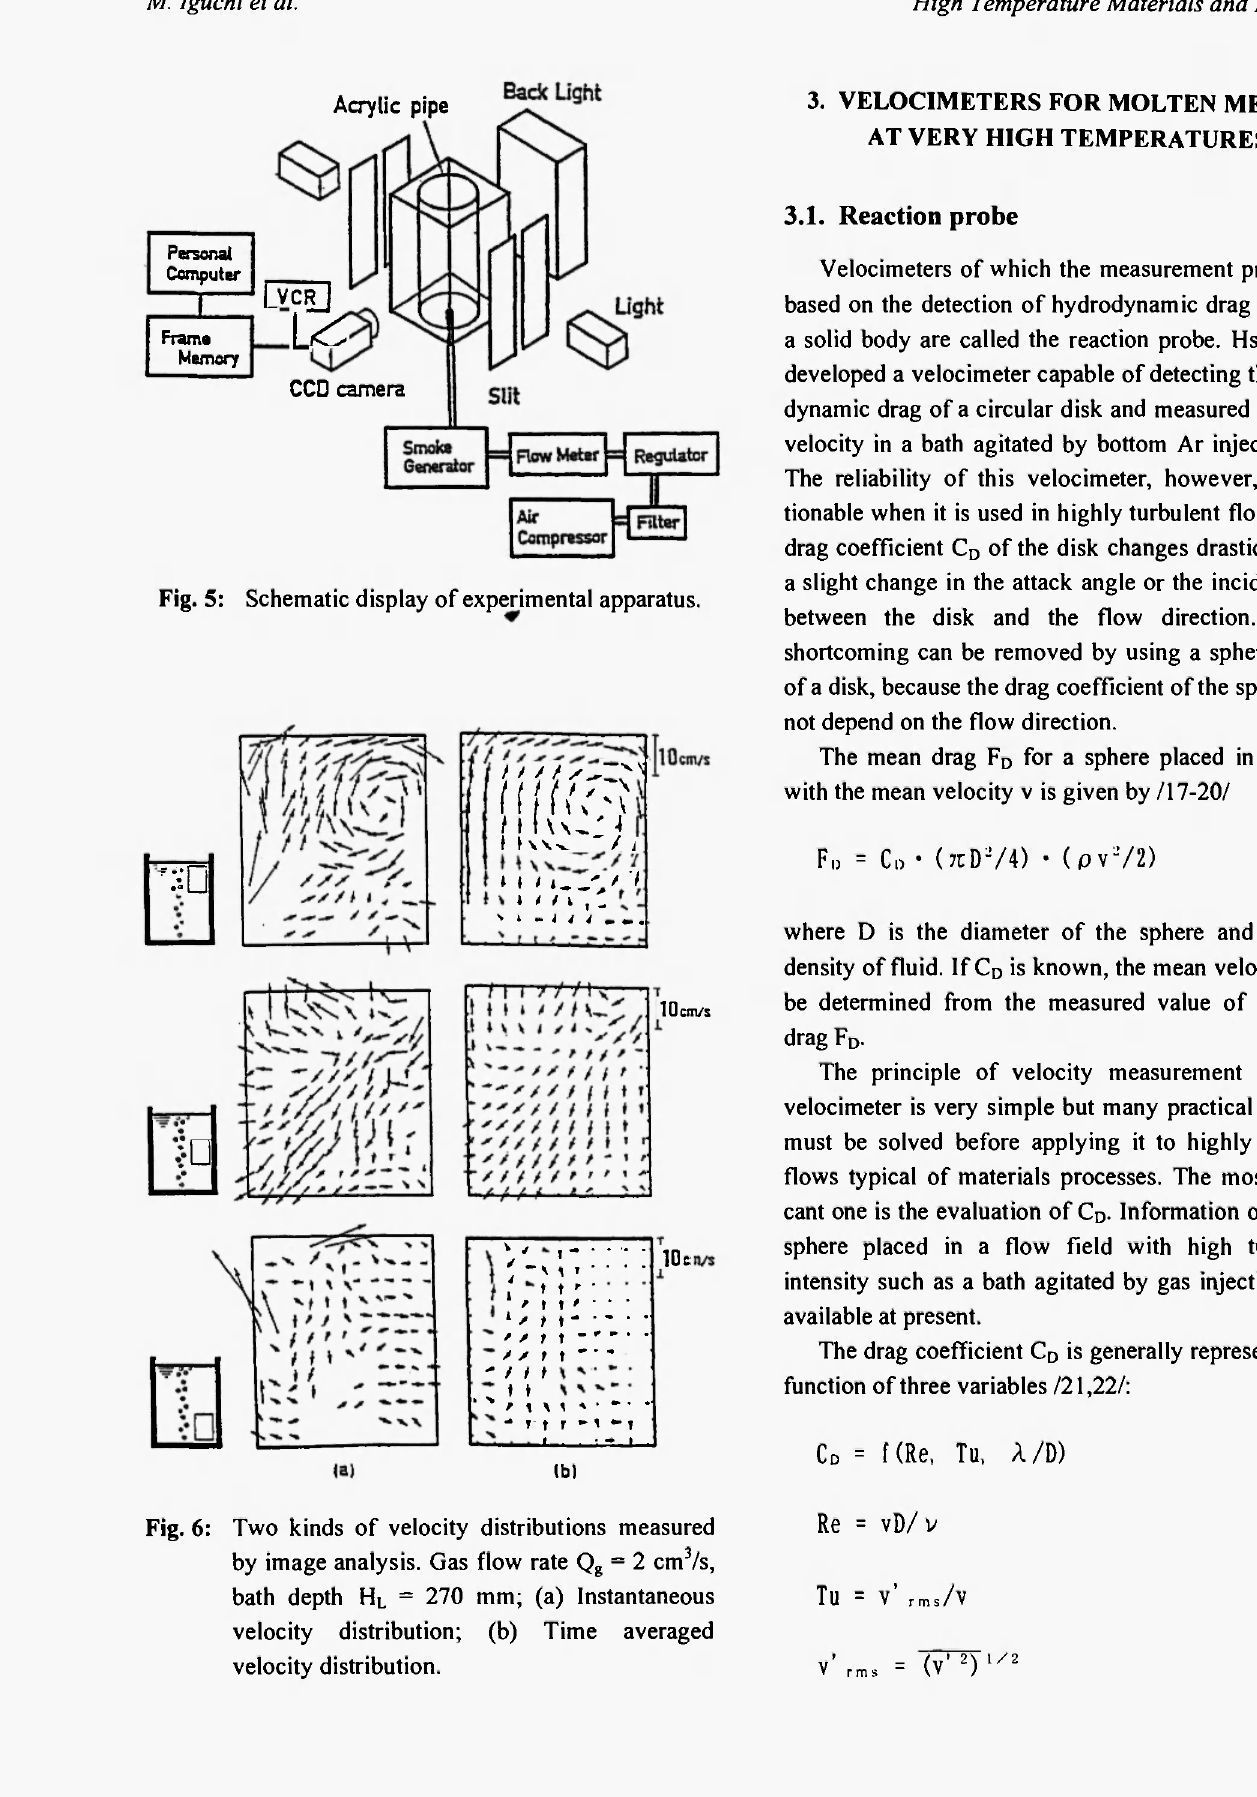
Fig. 5: Schematic display of experimental apparatus.